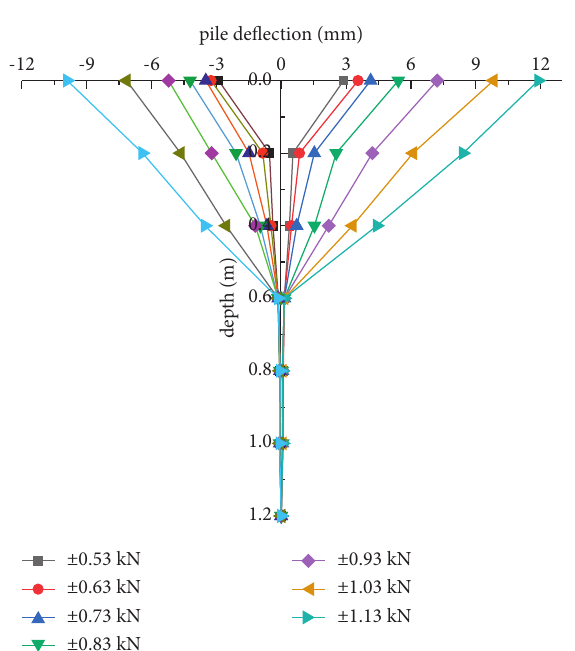
Figure 7: Variation of pile deflection with depth during LK2 positive and negative